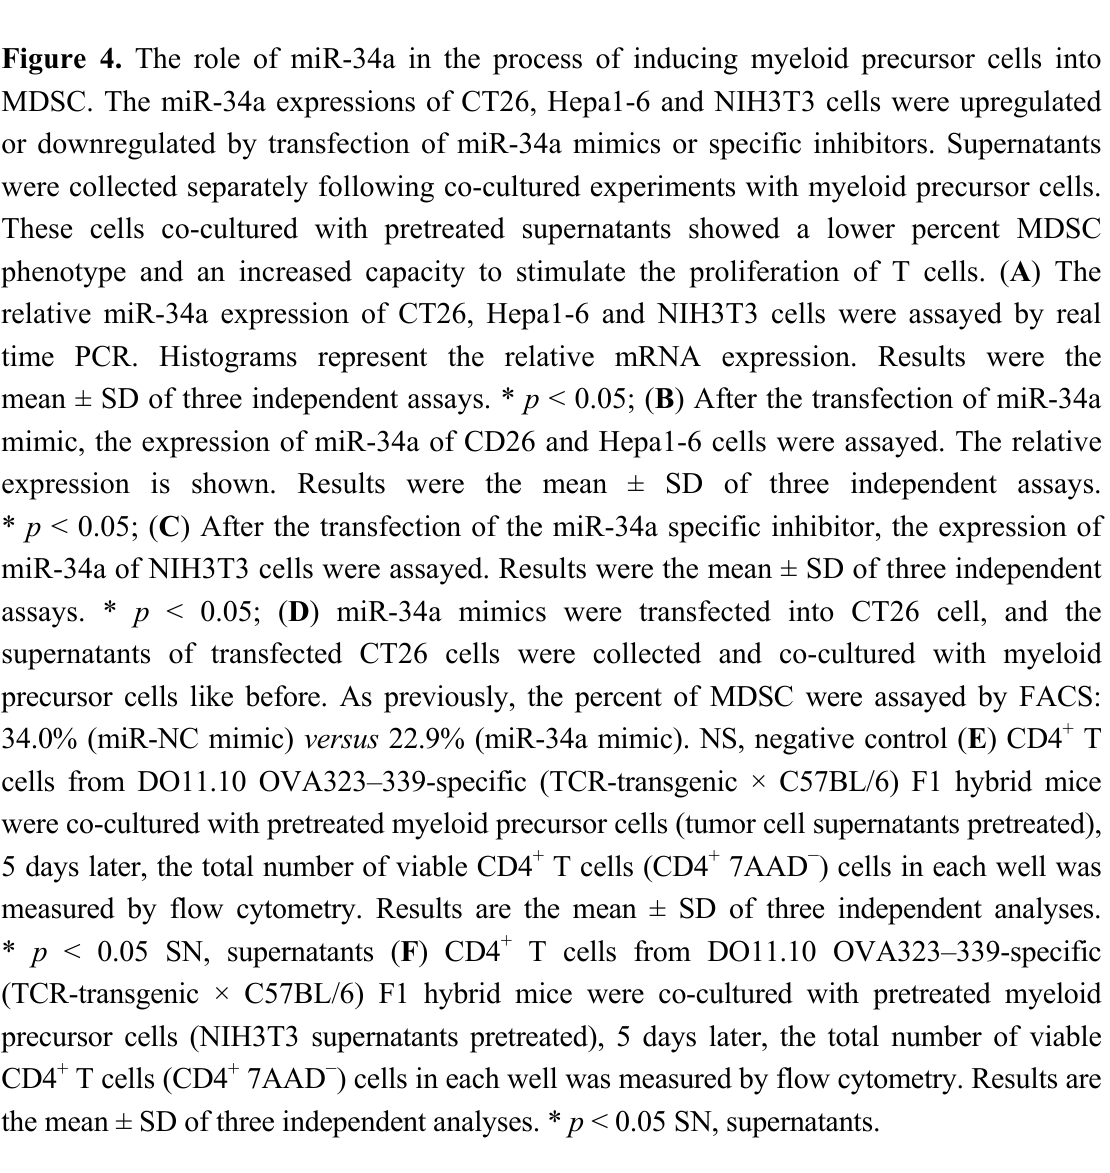
Figure 4. The role of miR-34a in the process of inducing myeloid precursor cells into MDSC. The miR-34a expressions of CT26, Hepa1-6 and NIH3T3 cells were upregulated or downregulated by transfection of miR-34a mimics or specific inhibitors. Supernatants were collected separately following co-cultured experiments with myeloid precursor cells. These cells co-cultured with pretreated supernatants showed a lower percent MDSC phenotype and an increased capacity to stimulate the proliferation of T cells. ( A ) The relative miR-34a expression of CT26, Hepa1-6 and NIH3T3 cells were assayed by real time PCR. Histograms represent the relative mRNA expression. Results were the mean ± SD of three independent assays. * p < 0.05; ( B ) After the transfection of miR-34a mimic, the expression of miR-34a of CD26 and Hepa1-6 cells were assayed. The relative expression is shown. Results were the mean ± SD of three independent